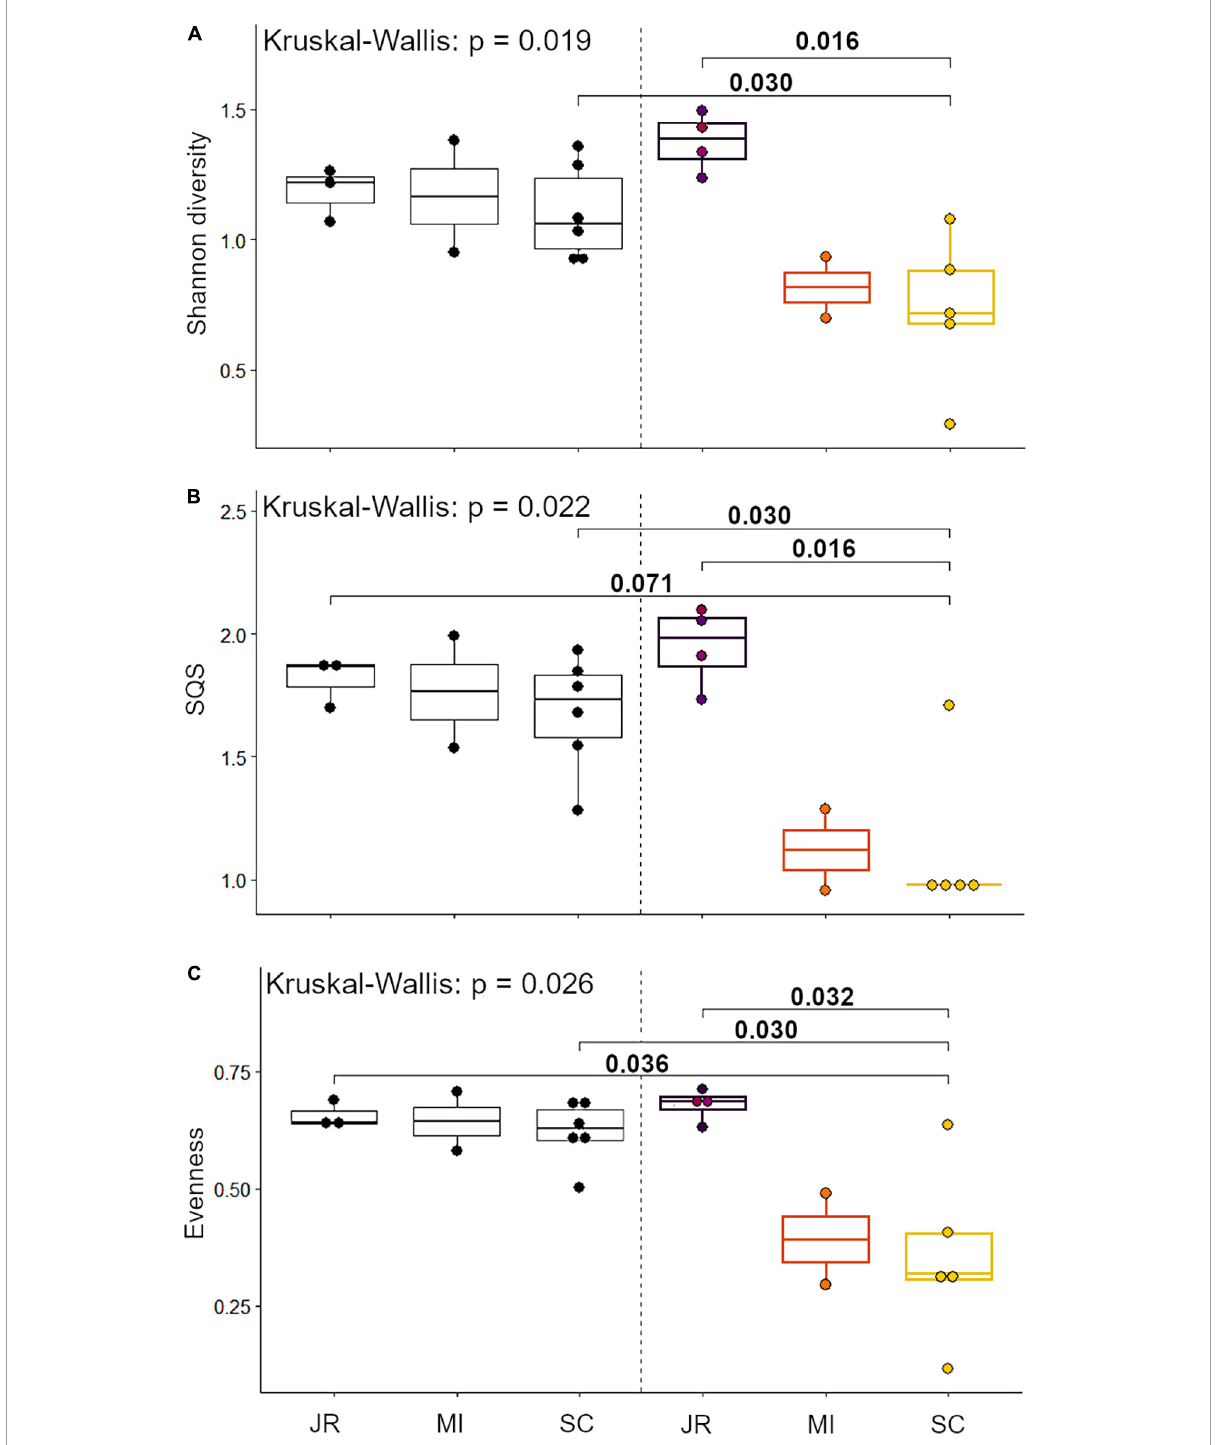
FIGURE3 Quantification of alpha diversity using (A) Shannon diversity, (B) shareholder quorum subsampling (with a quorum of 0.7 and 1,000 iterations), and (C) probability of interspecific encounter across Holocene and Anthropocene sites (JR, Jasper Ridge; MI, Middle, SC, Stanford Campus). Anthropocene points colored based on human modification scores according to the scale in Figure 1 . Scores and colors were averaged when multiple collection sites were binned. Pairwise comparisons done using a Wilcoxon test.